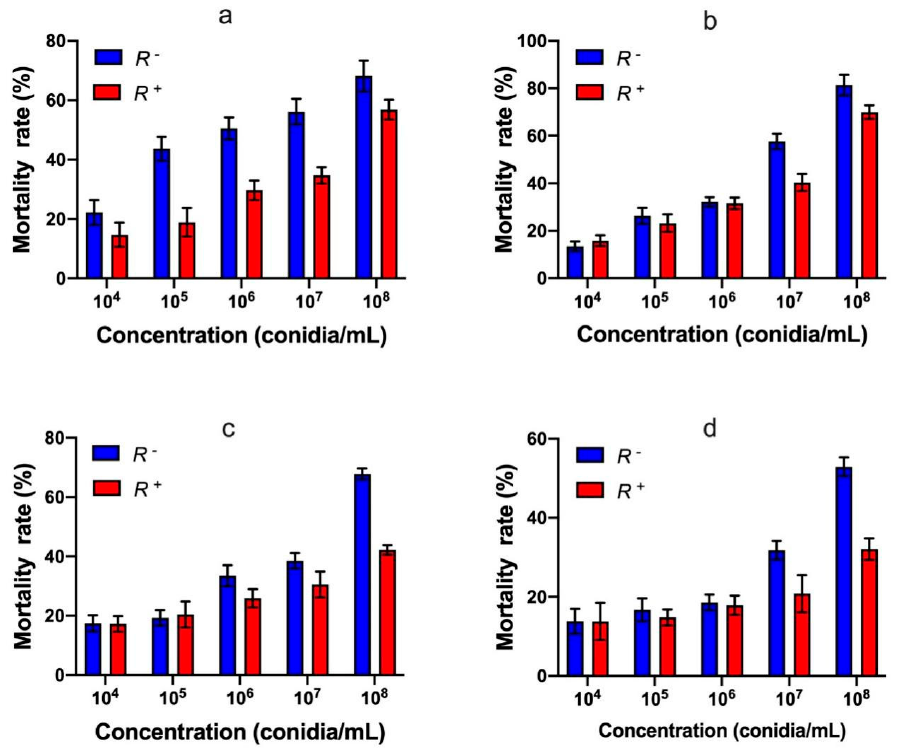
Figure 4. The effect of Akanthomyces attenuatus SCAUDCL53 on the mortality rate of the first instar ( a ), second instar ( b ), third instar ( c ) and fourth instar ( d ) nymphs of Rickettsia positive ( R + ) and Rickettsia negative ( R − ) B . tabaci MEAM1 cryptic species. Table 1. Virulence of Akanthomyces attenuatum SCAUDCL53 against different Rickettsia positive and Rickettsia negative developmental stages of B . tabaci .